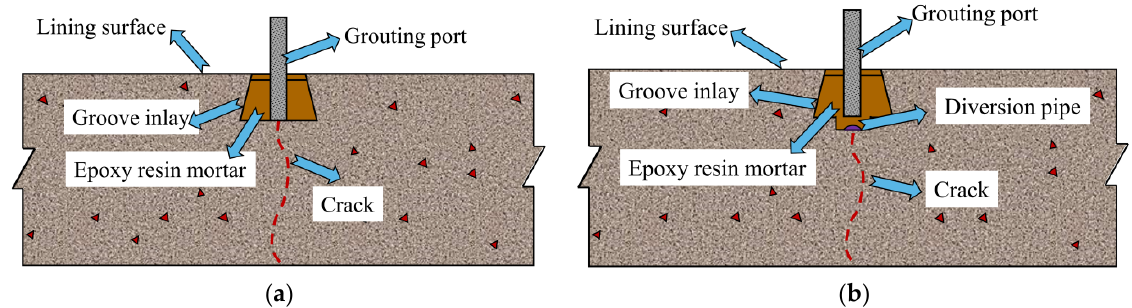
Figure 14. Crack treatment on lining surface: ( a ) no seepage; ( b )